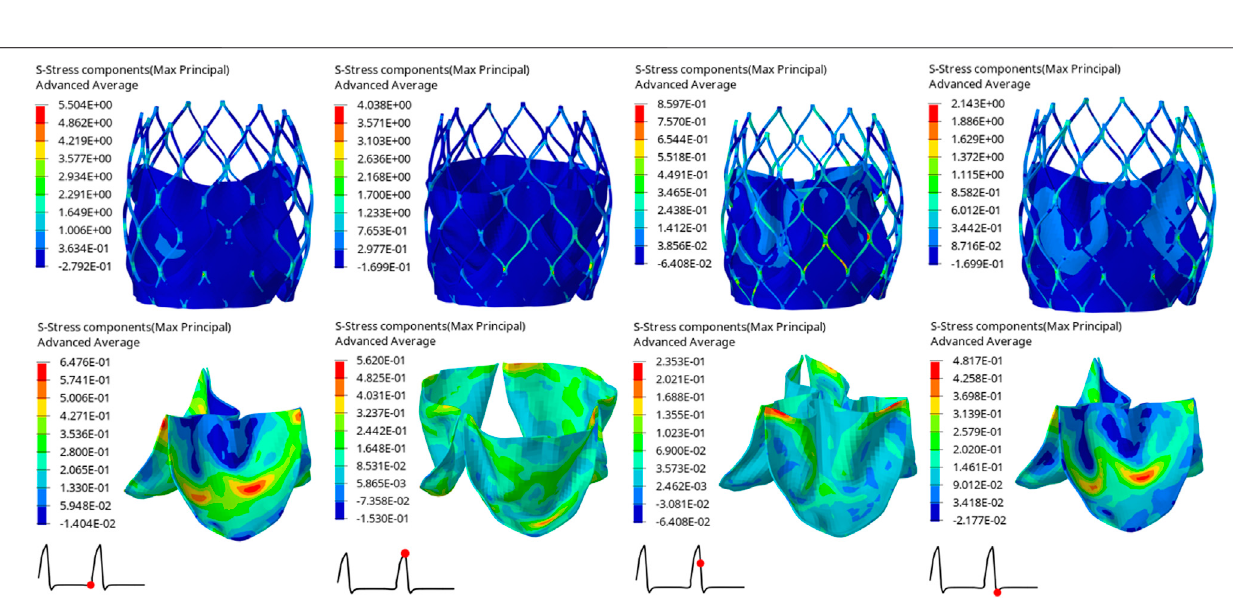
Frontiers in Physiology |